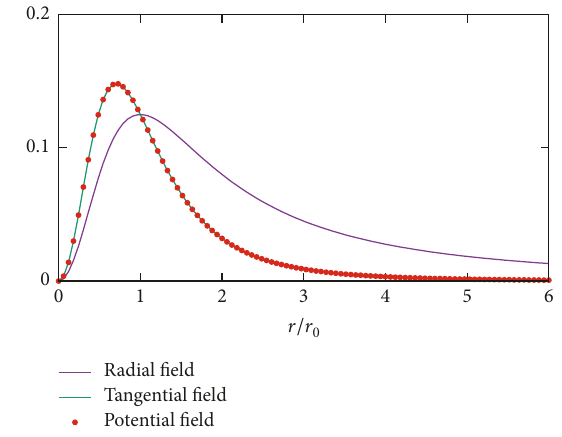
Figure 1: Contributions to the radial energy density according to (8) in units of 𝛼 푓 ℏ𝑐/𝑟 0 .